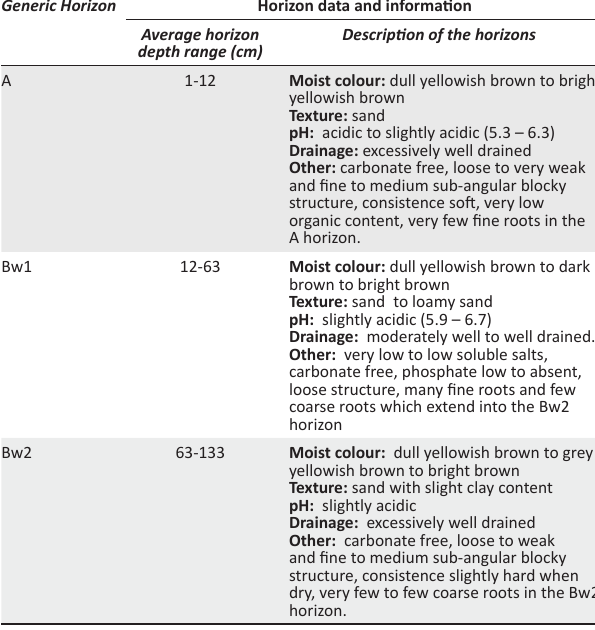
TABLE A1.6b: Differentiating characteristics of haplic Arenosols.